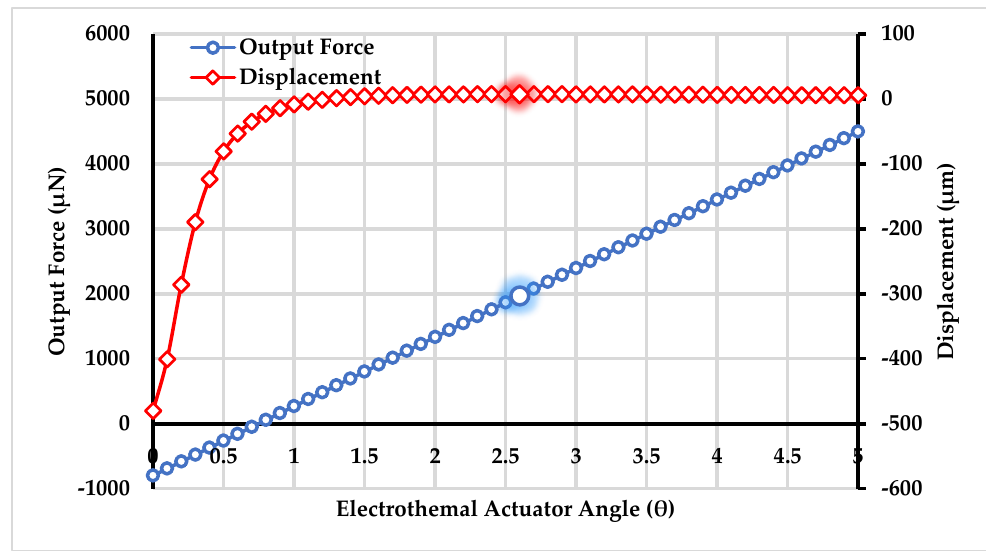
Figure 5. Stiffness values of the electro-thermal actuator with angle variations.